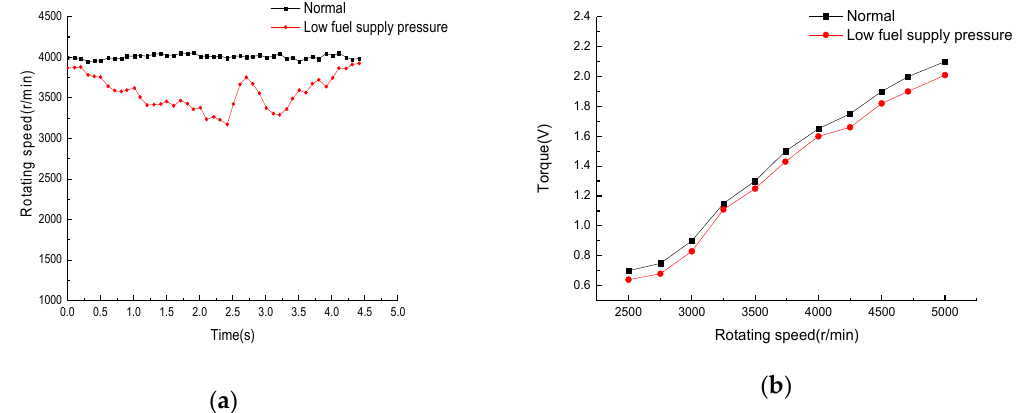
Figure 4. Rotating speed and torque change diagram. ( a ) Curve of rotating speed varying with time, ( b ) Curve of torque varying with time .